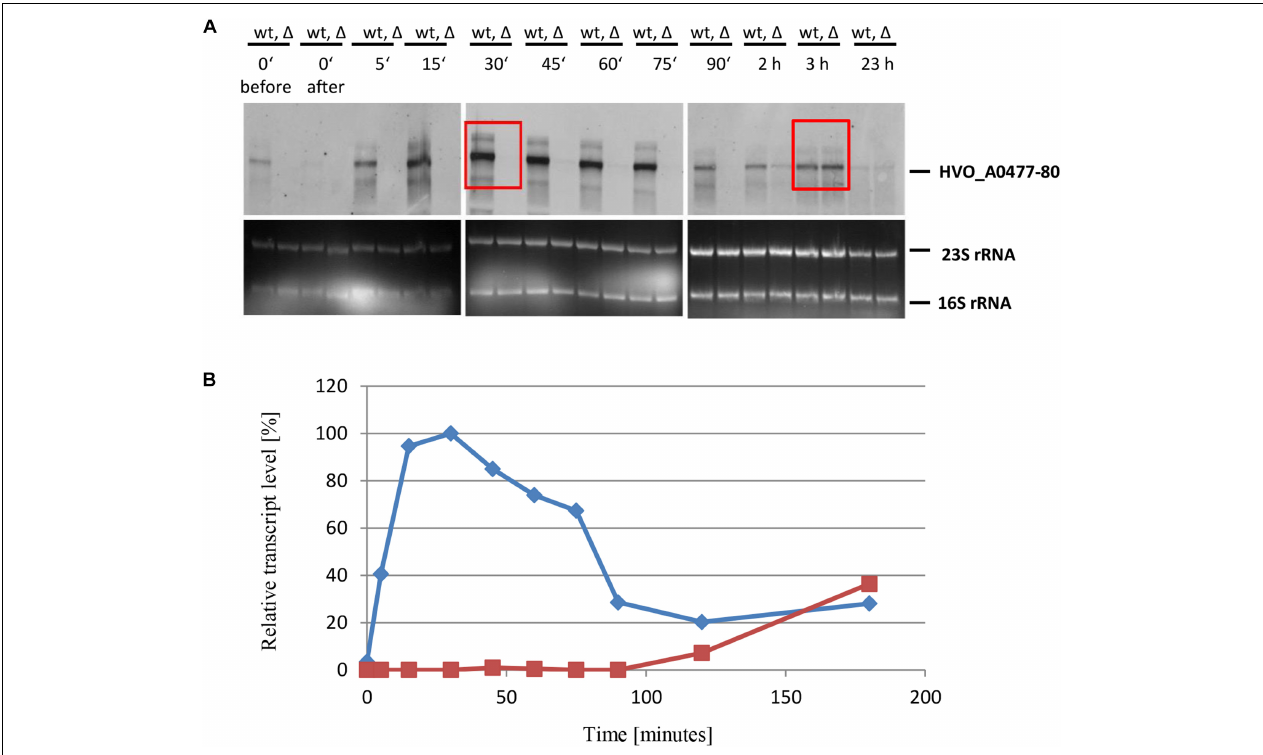
FIGURE 4 | Kinetic analysis of the HVO_ A0477-A0480 operon mRNA level after the onset of phosphate starvation. (A) The operon encodes a phosphate-specific ABC transporter. The wild-type (wt) H26 and the sRNA132 gene deletion mutant ( (cid:49) ) were grown to mid-exponential growth phase in the presence of phosphate (1 mM). The cells were harvested and resuspended in phosphate-free medium. At the time points indicated at the top aliquots were removed, RNA was isolated and used for Northern blot analysis with an operon-specific probe. Ethidium bromide stained 23S and 16S rRNAs are shown at the bottom. The two red boxes highlight time points discussed in the text. (B) The signals of the Northern blots were quantified densitometrically, and the kinetic changes of relative transcript levels are